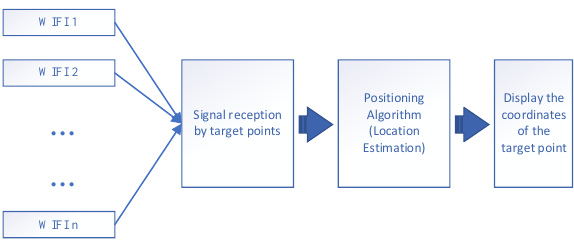
Figure 2 . The online phase includes receiving the signal by the target point and determining the position with location estimation algorithms 2.2 NEAREST